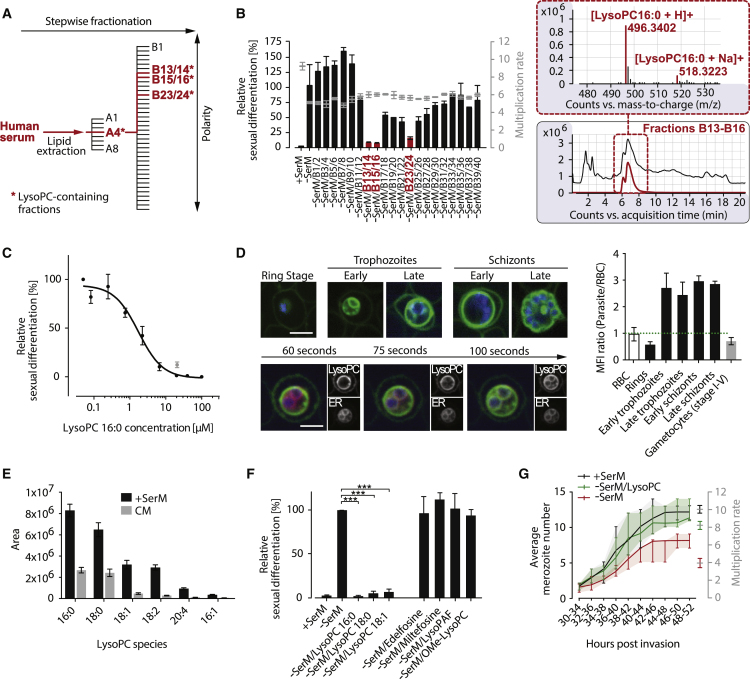
Identification of LysoPC as a Regulator of Transmission-Stage Formation in P. falciparum(A) Polarity-based separation of serum components yields LysoPC-enriched fractions with sexual differentiation-inhibiting activity (highlighted in red). See Figure S1 for details on activity and composition of fractions.(B) Sexual commitment inhibiting activity of LysoPC-containing fractions (left panel) and LC-MS chromatograms and mass spectra of most active fractions (right panel) are shown. An extracted ion chromatogram for the [M+H]+ ion of LysoPC (16:0) is highlighted in red. Bars in the left panel quantify sexual differentiation normalized to a −SerM-exposed control population. n = 3, data from a representative experiment is shown. Standard deviations of technical triplicates are indicated.(C) LysoPC inhibits sexual differentiation of Pf2004/164tdTom parasites (half maximal inhibitory concentration [IC50]). Effect of 20 μM LysoPC on HB3/748tdTom parasites is shown in grey. Sexual differentiation is normalized to −SerM-cultured control populations. n = 3, standard errors are shown.(D) LysoPC is internalized by asexual P. falciparum parasites. Uptake was analyzed by live microscopy using TopFluor-labeled LysoPC (green), ER tracker (red) and DNA dye Hoechst (blue). Incorporation is apparent after completion of ring stage development (upper left panel) and the label accumulates at the ER of trophozoites within 75 s after addition of TopFluor LysoPC (lower left panel). LysoPC uptake in the parasite is quantified relative to accumulation at the erythrocyte surface (right panel). Mean fluorescence intensities (MFIs) and standard deviations are shown. Scale bar, 4 μm. 100 cells were analyzed per stage in triplicate experiments.(E) LysoPC is depleted in parasite-exposed CM. Bars quantify area under the curve. n = 3, standard errors are shown.(F) In contrast to different LysoPC species, non-hydrolyzable analogs of LysoPC fail to prevent −SerM-induced sexual differentiation. All molecules were tested at 20 μM. n = 3, standard deviations are shown, ∗∗∗ p < 0.001, Student’s t test. See Figure S1C for chemical structures.(G) LysoPC-depleted culture conditions (−SerM) result in reduced number of daughter merozoites per schizont (left axis) and reduced multiplication rate (right axis) compared to +SerM and −SerM/LysoPC conditions. n = 100. Interquartile ranges are shown.See also Figures S1 and S2.